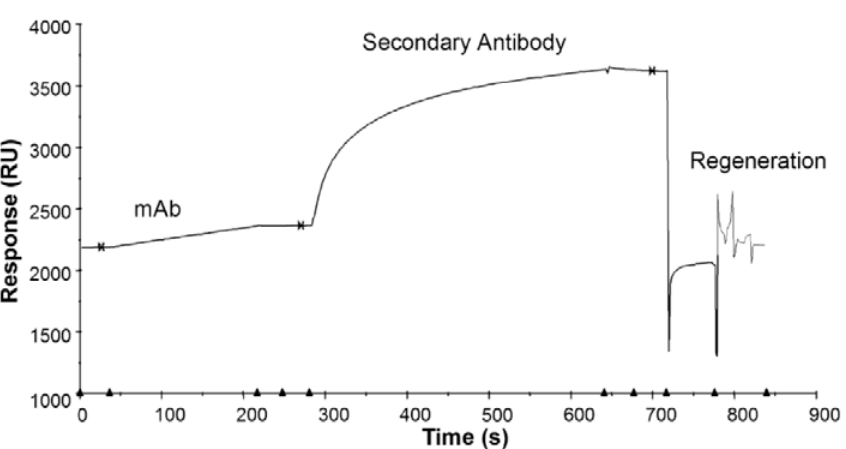
Figure 3. A sensorgram of the primary monoclonal antibody (mAb) binding response to a progesterone-immobilized SPR sensor surface and enhancement of binding signal with secondary antibody followed by regeneration. Reprinted from reference [4], with permission from Elsevier. Copyright